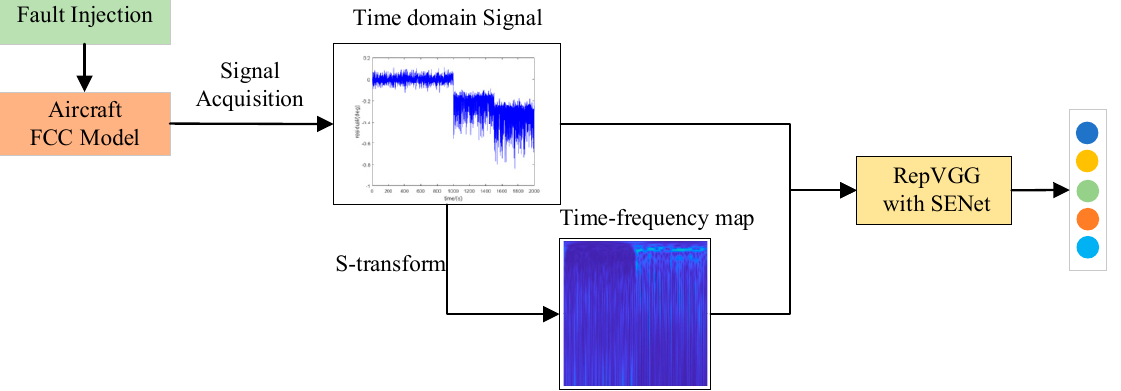
Figure 4. Flowchart of the algorithm proposed in this paper.